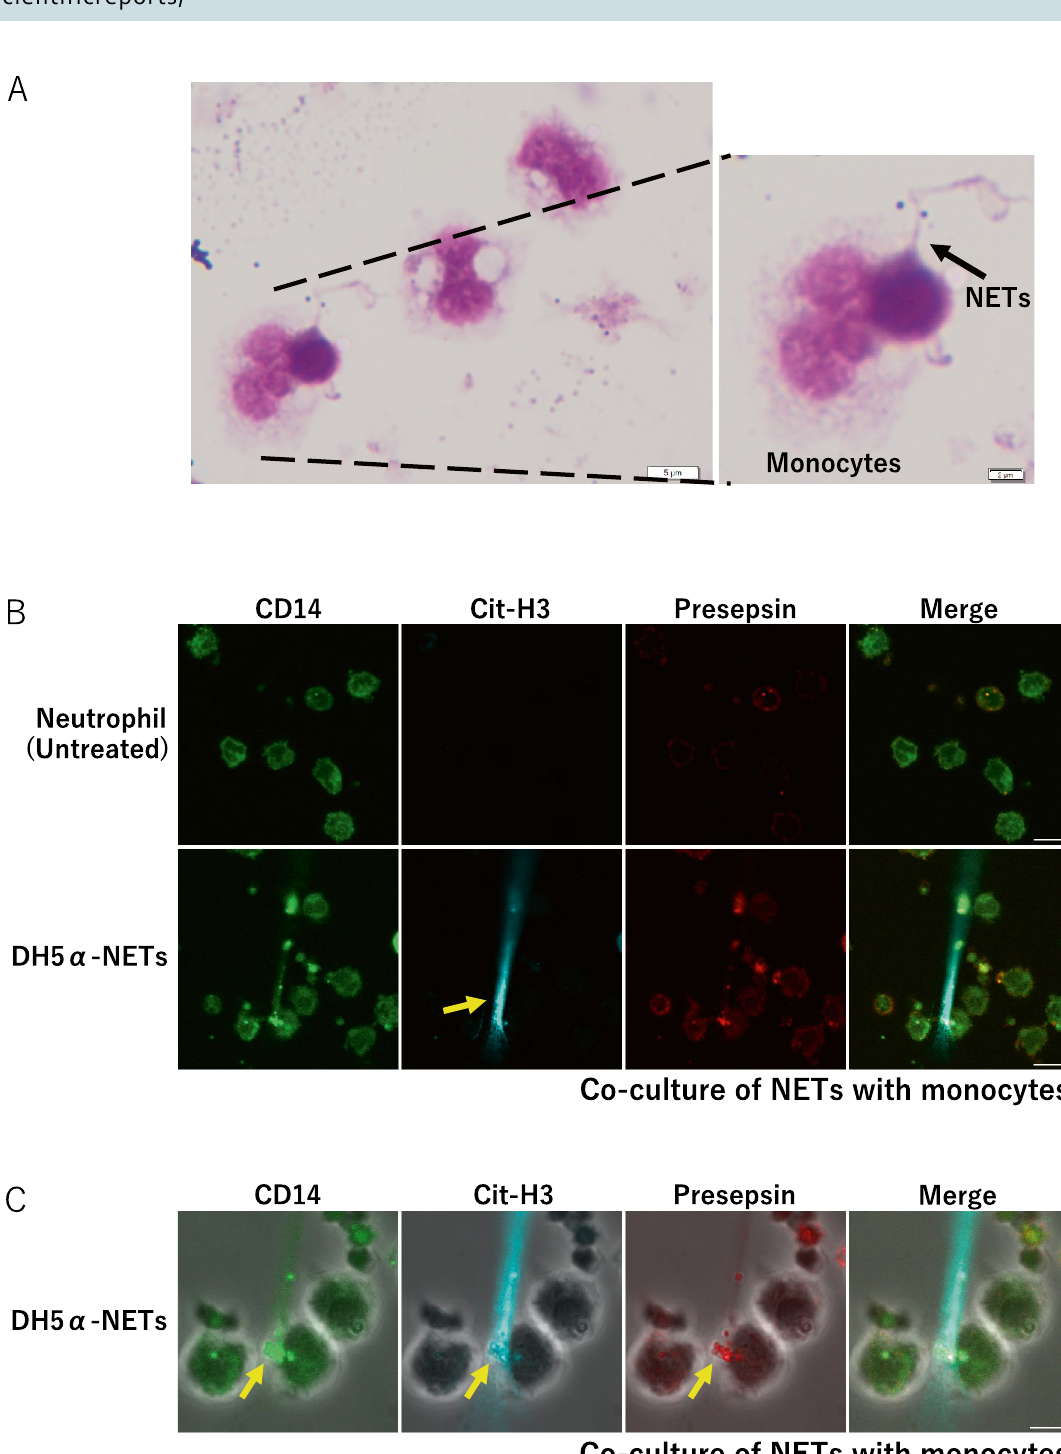
Figure 3. Presepsin levels increase as the monocytes phagocytose NETs. ( A ) A May–Giemsa-stained image 3 h after PMA-NETs were induced and co-cultured with monocytes. (1,000 × magnification). The scale bar is 5 μm, and the scale bar in the magnified image is 2 μm. ( B ) Immunofluorescence imaging of co-culture with monocytes after induction of DH5α-NETs. The arrow shows cells positive for citrullinated histones. Scale bar: 10 μm. ( C ) The arrow point indicates the area where monocytes are phagocytosing NETs. The scale bar in the magnified image is 5 μm. ( D ) Presepsin levels in DH5α (OD 1.0)-NET induction (NET ratio 14%), presepsin levels in PMA (50 nM)-NETs induction (NET ratio 23%). ( E ) Comparison of presepsin levels after phagocytosis by co-culturing with monocytes for 3 h. ( F , G ) Variation in NET ratio and presepsin values with DH5α and PMA concentrations are shown. * p < 0.05 and ** p < 0.001, when compared with untreated neutrophils. Data represent the mean values ± SD of at least three experiments. NS, not